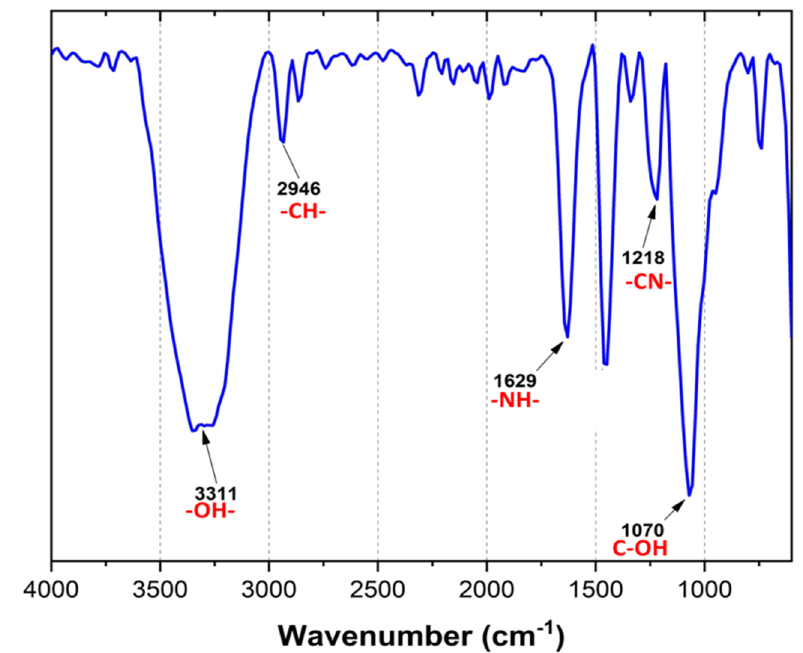
Figure 3. Fourier transform infrared spectroscopy (FTIR) spectrum of the polyamine ( Polycoat 38 ® ) resin synthesized.